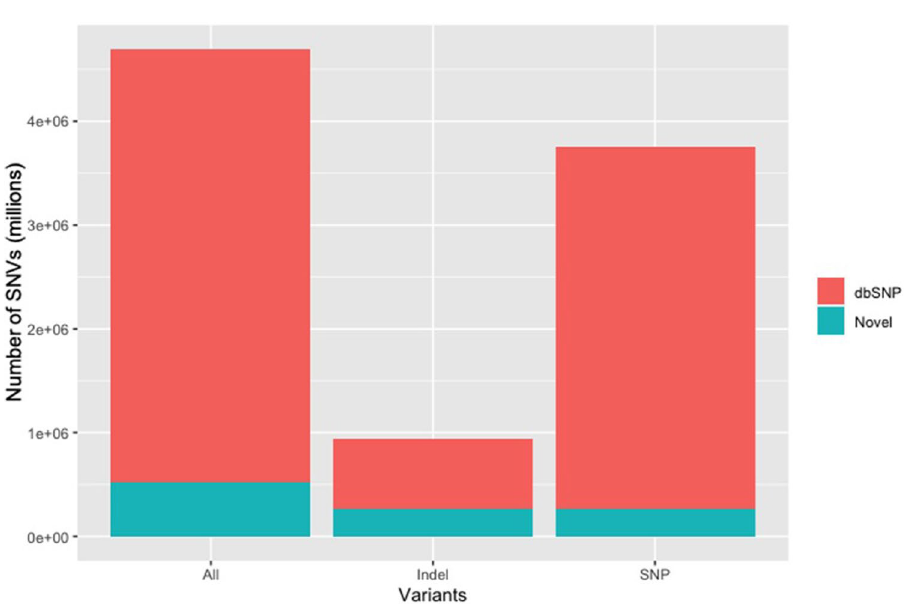
Figure 5. Average number of single nucleotide variants (SNVs) in all of the